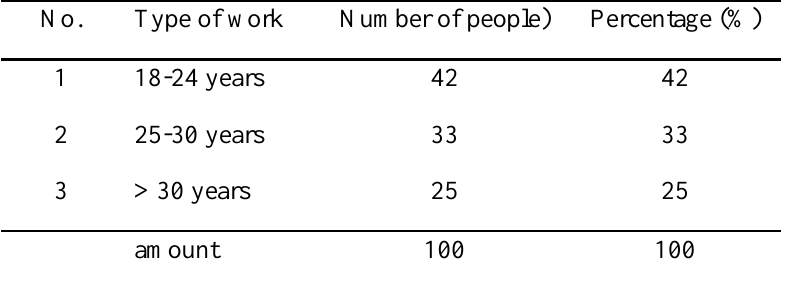
Respondents by Age